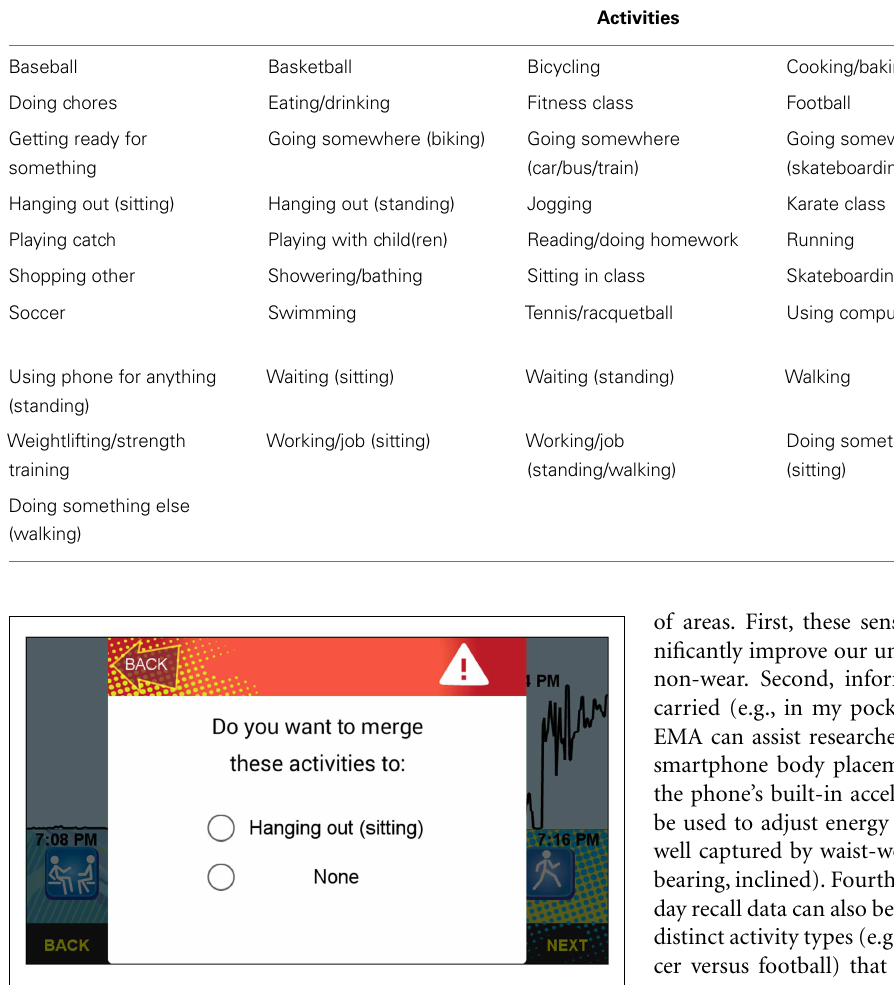
FIGURE 6 | Screenshot of the merging feature of the sensor-assisted end-of-day recall component .